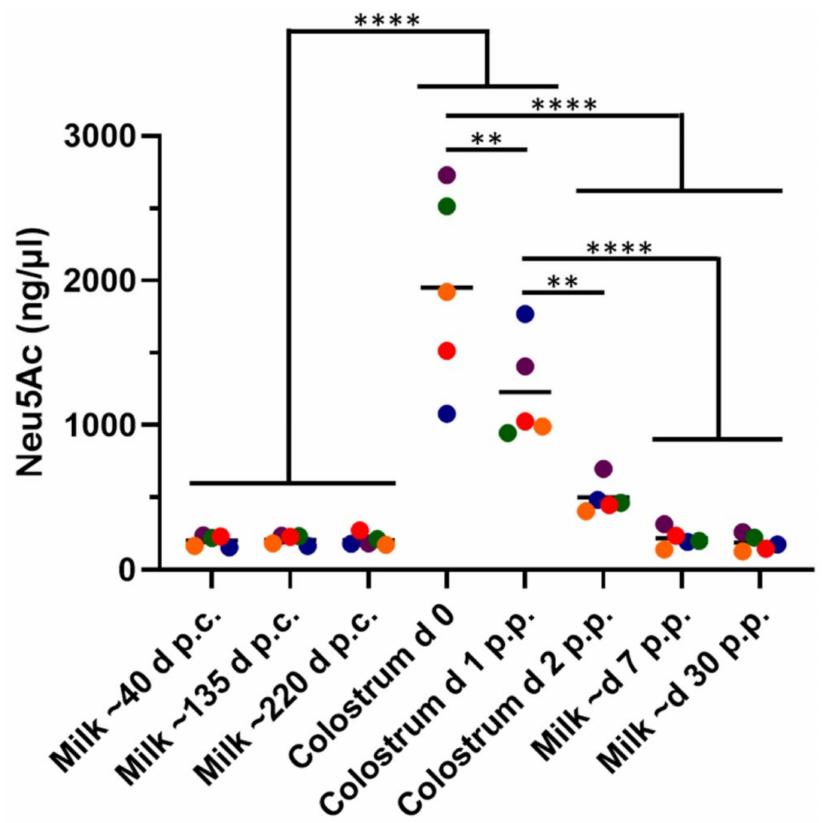
Figure 1. The Neu5Ac concentration decreased during early lactation. The amount of Neu5Ac was determined by RP chromatography after DMB-labeling. Milk samples of five animals were collected at the given time points. The Neu5Ac concentrations of each animal are displayed in the diagram, in addition to the mean values. ANOVA and multiple comparison Tukey test were applied. Significant differences were as follows: ** p ≤ 0.01; **** p ≤ 0.0001. p.c. = post conception, p.p. = postpartum, d =